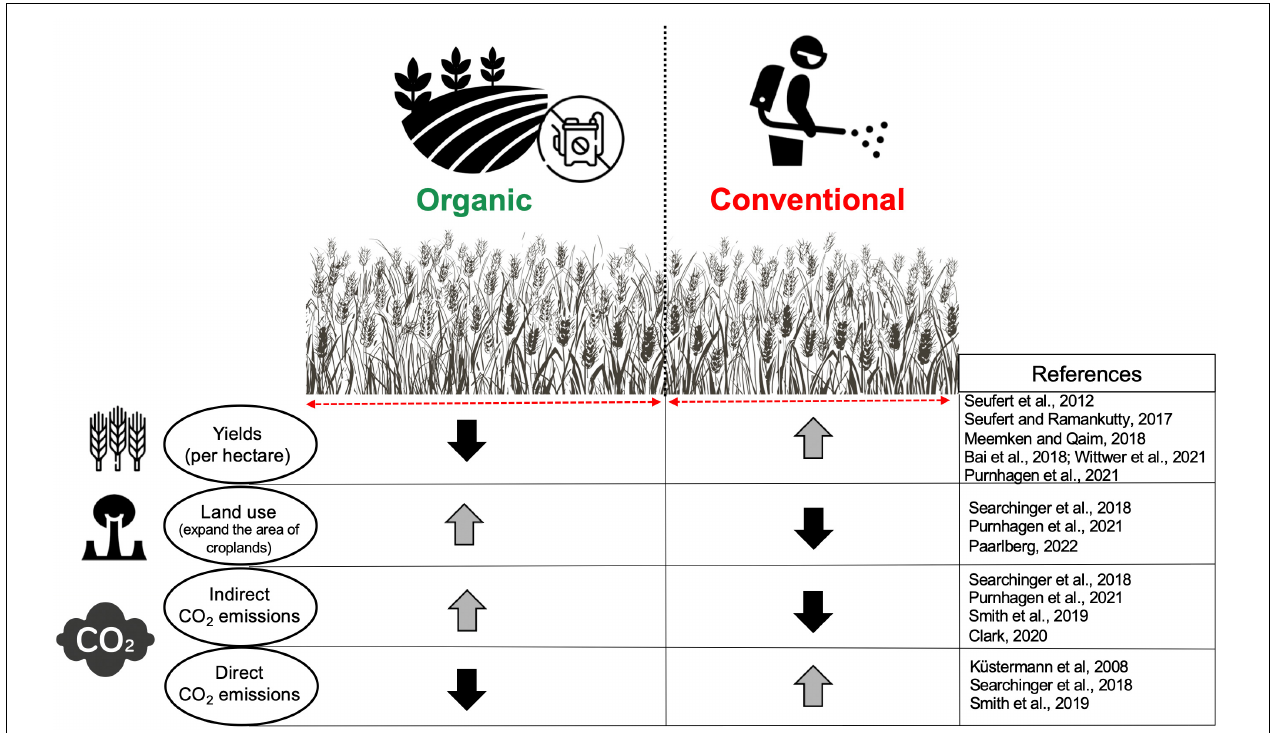
FIGURE 1 | The comparisons between organic and conventional agriculture in terms of yield and environmental effects. The direction of the arrows indicates an increase or decrease in the considered factors.